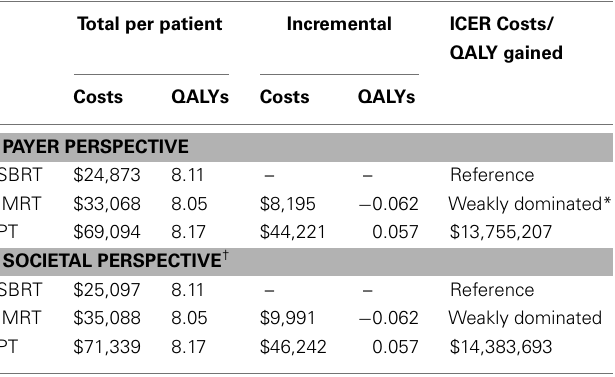
Table 8 |Alternative sensitivity analysis with proton therapy toxicity set equal to SBRT